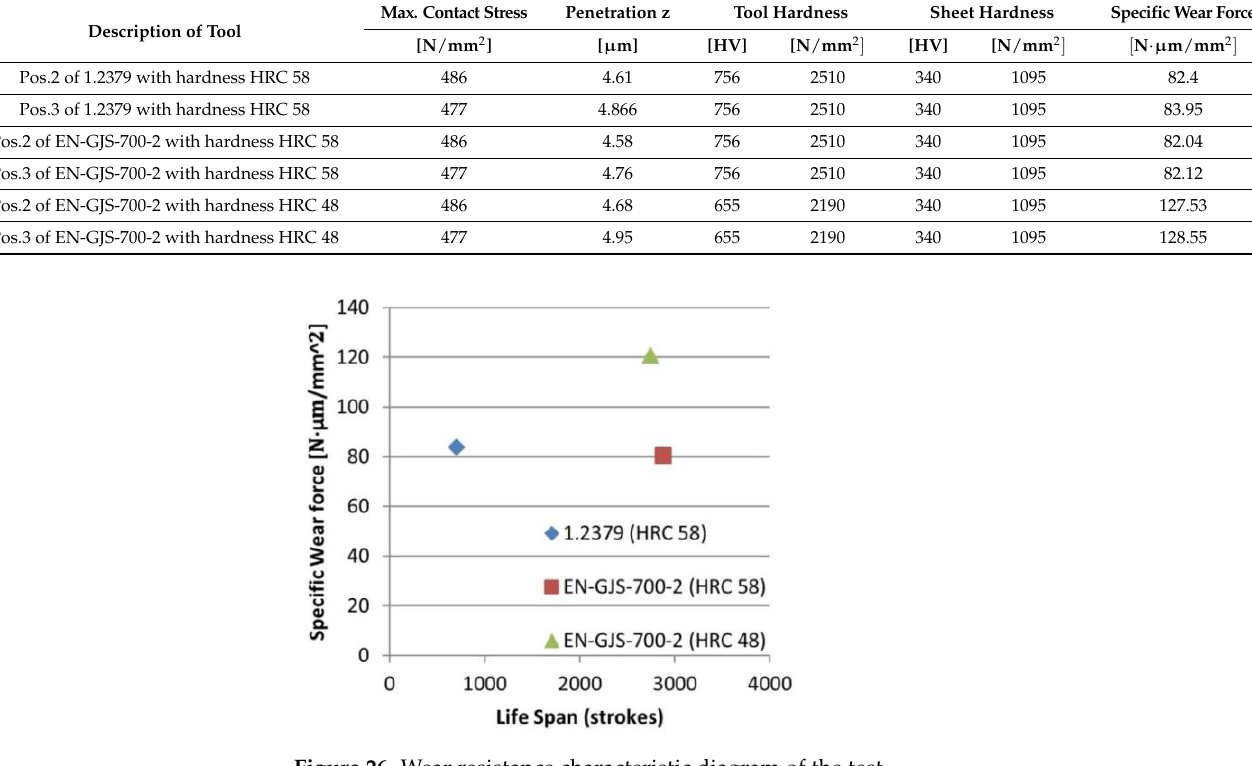
Figure 26. Wear resistance characteristic diagram of the test.